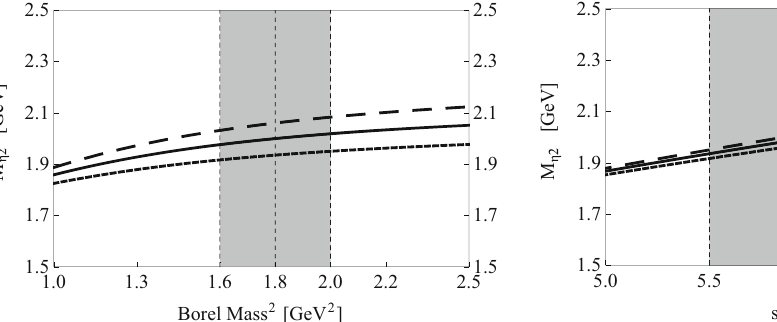
Fig. 4 The mass extracted from the current η 2 μ , denoted as M η a function of the Borel mass M B (left) and the threshold value s 0 (right). In the left panel, the short-dashed/solid/long-dashed curves are